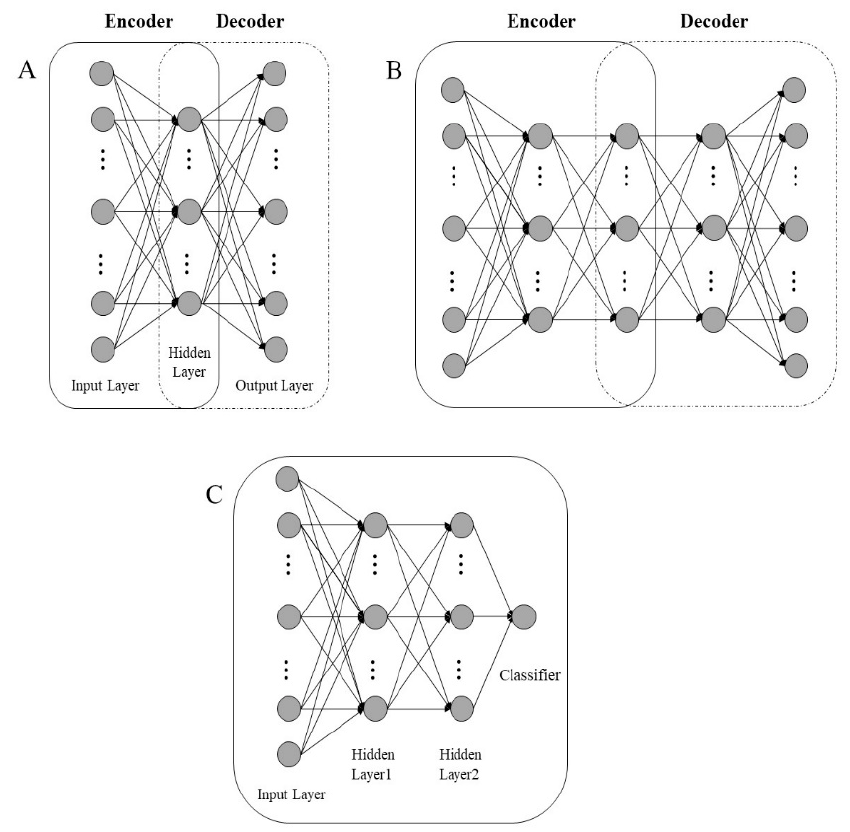
Figure 7. The structure of ( A ) basic sparse auto-encoder, ( B ) SSAE, and ( C ) SSAE with